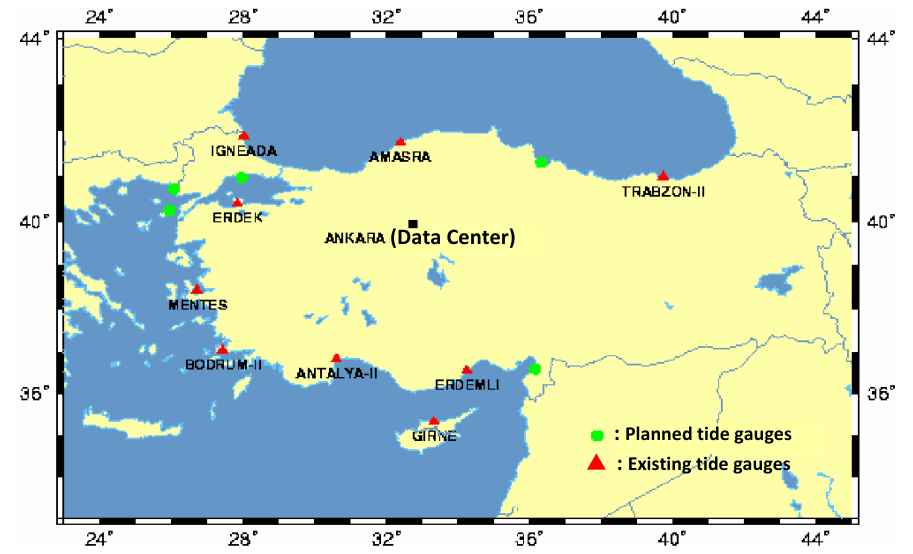
Figure 1. TUSELS tide-gauge stations in Turkey